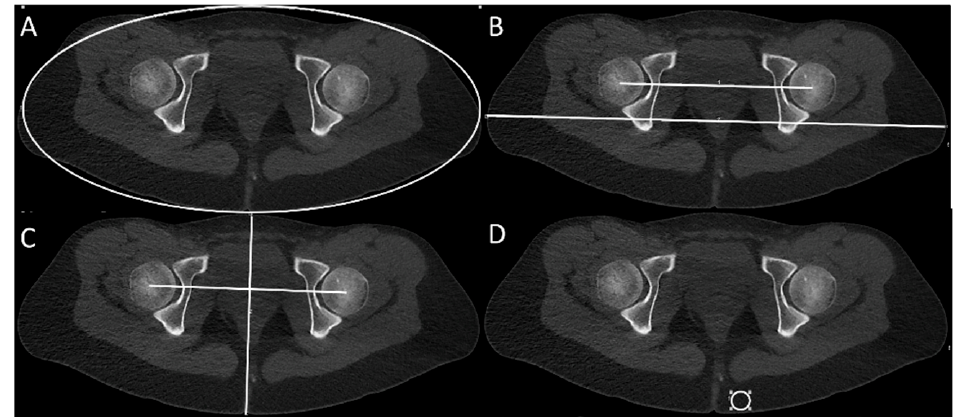
Figure 3. Measurement of body contour parameters at the femoral head level: best ellipsoid adap- tation to the body contour ( A ), maximum body diameter right-left (RL) ( B ), and maximum body diameter anterior-posterior ( C ). Measurement of image noise in subcutaneous fatty tissue and con- trast (cortical bone and surrounding skeletal muscle) at standardized anatomical positions for the calculation of CNR (contrast-to-noise ratio) ( D ).